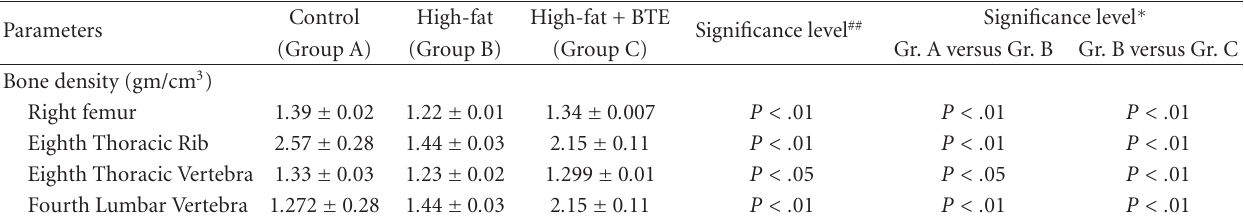
Table 3: Density of femur, eighth thoracic rib, eighth thoracic vertebra, and fourth lumbar vertebra in control group (Group A), HFD group (Group B), and HFD + BTE supplemented group (Group C) of rats.